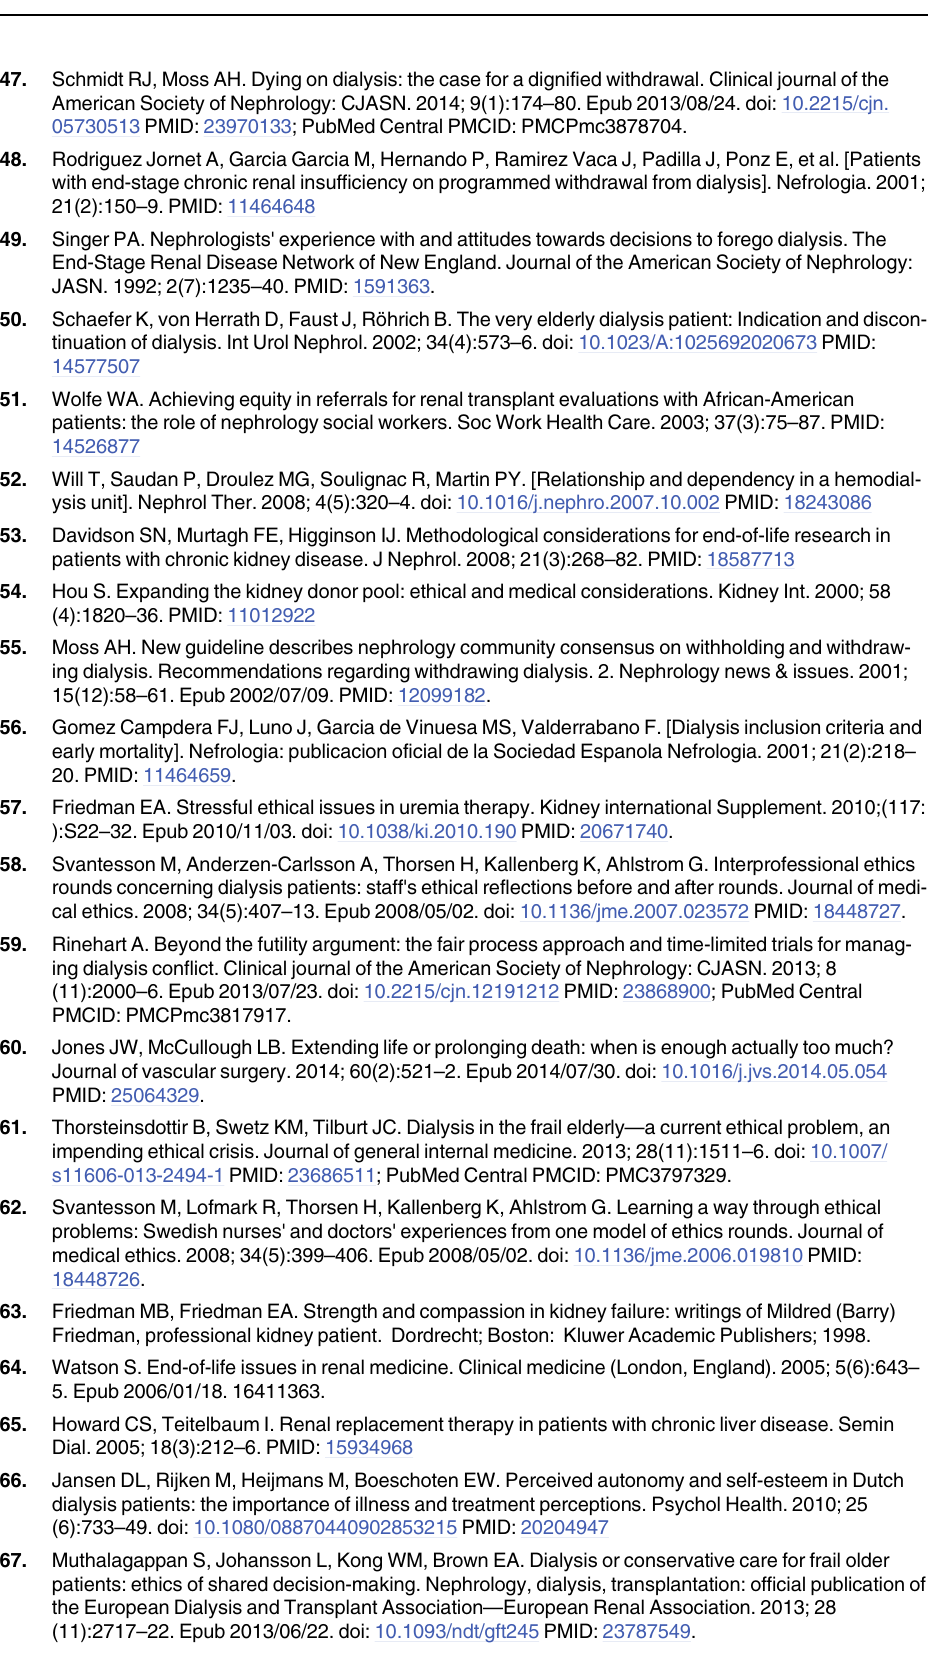
PLOS ONE | DOI:10.1371/journal.pone.0149357 March 3,